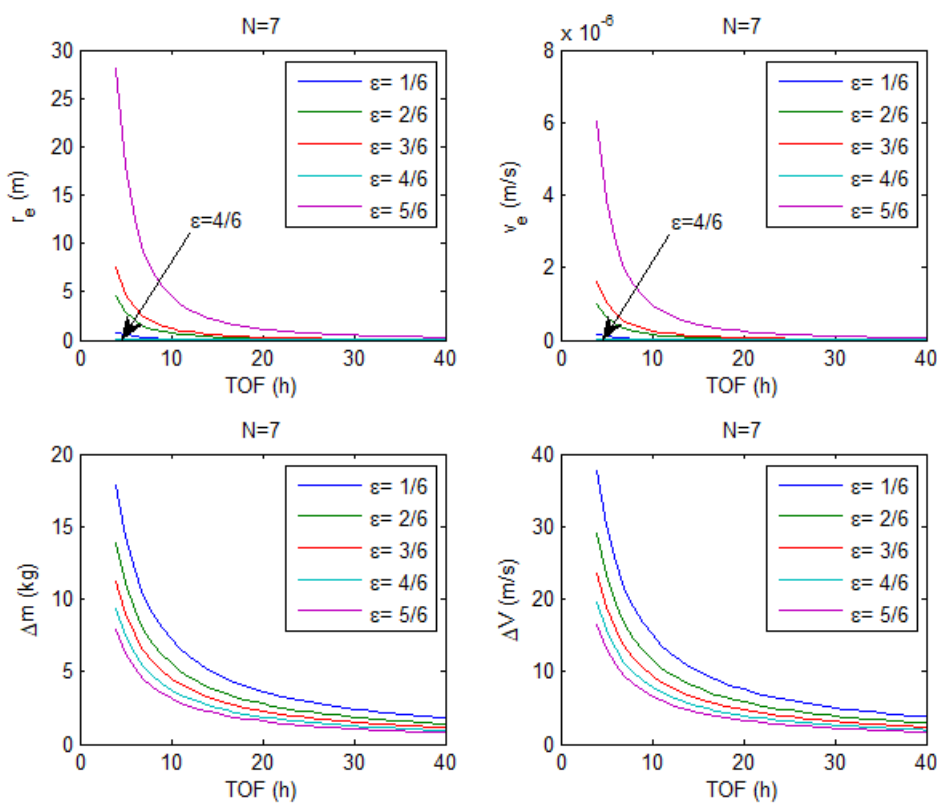
Figure 3. Control performance (baseline trajectory, = 7 N ).